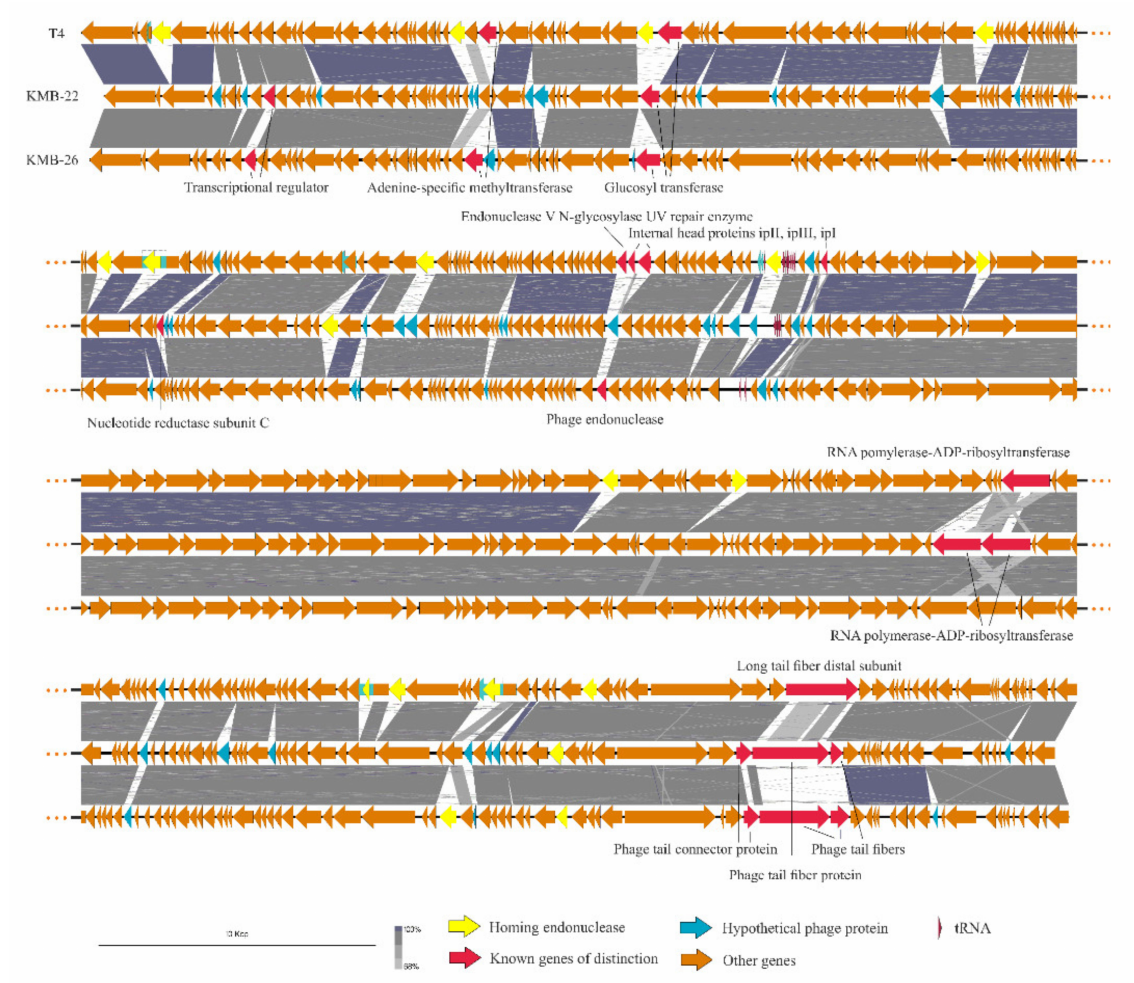
Figure 1. Comparison of phages used in the cocktail with the T4 phage;; analysis and visualisation were conducted in easyfig